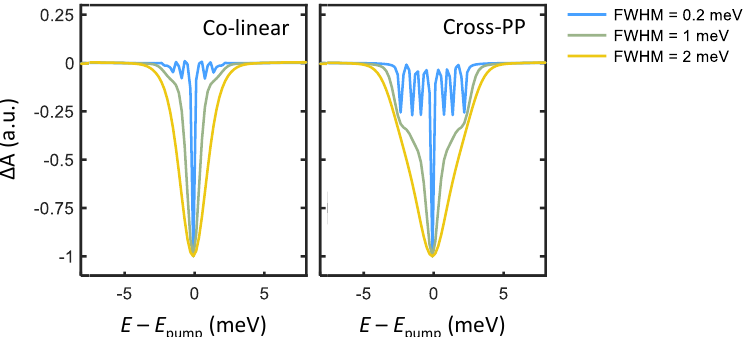
Figure 3. Transient absorption simulated for co-linear ( left ) and cross-linear ( right ) excitation at a pump-probe delay T = 1 ps. Three curves of varying pump spectral selectivity are simulated for each polarization scheme, with pump spectra centered at E pump = 2590 meV and FWHM of 0.2, 1, and 2